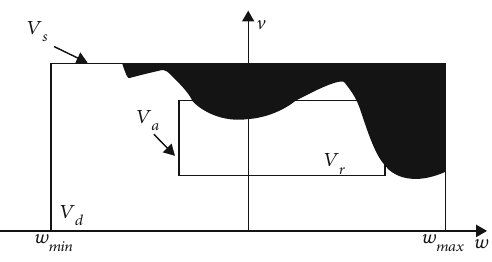
Figure 6: Schematic diagram of the velocity vector space.